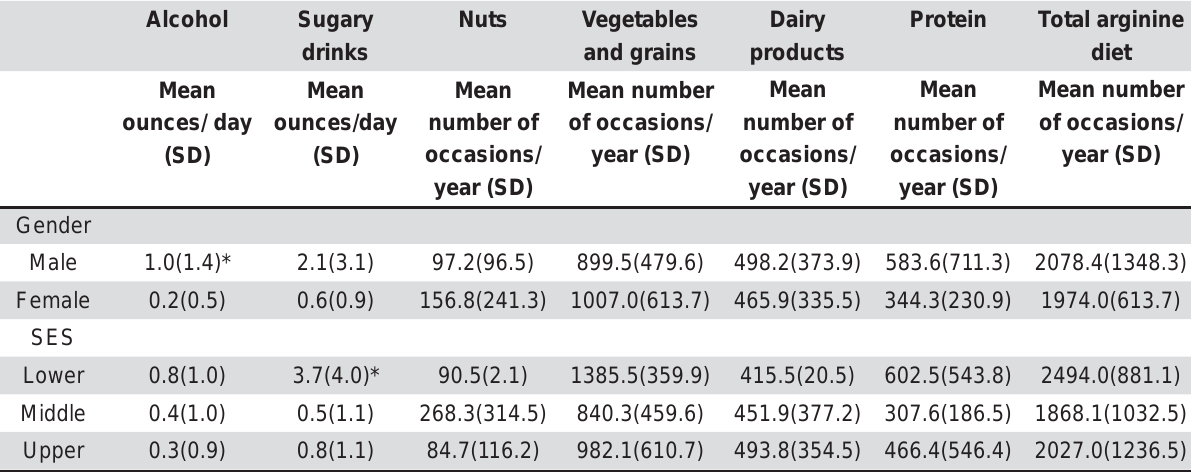
Table 2- Summary of alcohol and sugary drinks consumption, and diet according to gender and socio-economic status (SES)